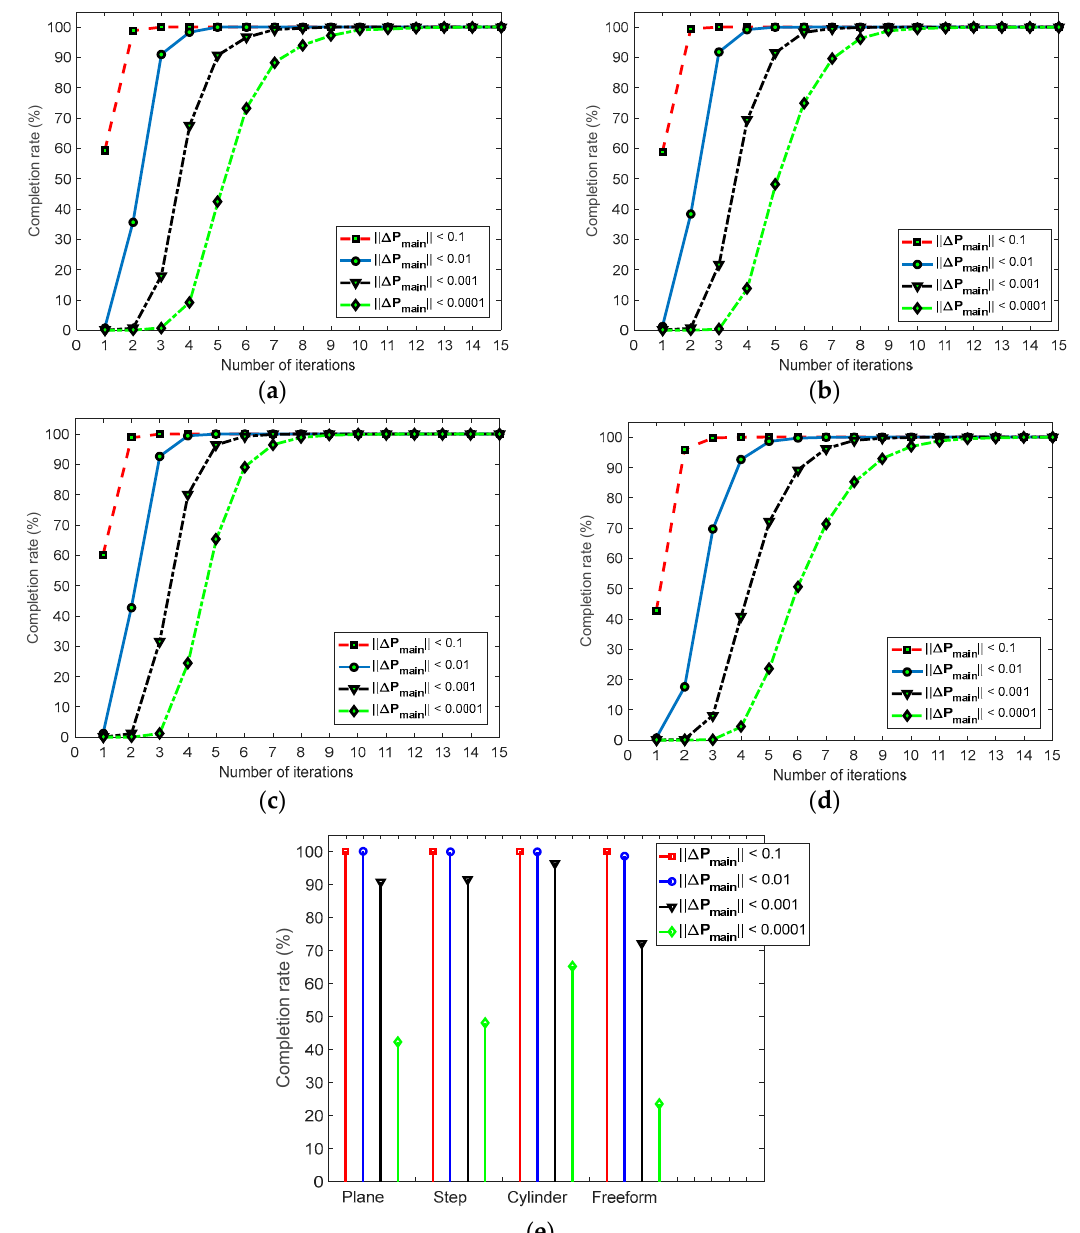
Figure 9. Efficiency evaluation of proposed seed point generation method: ( a ) plane surface; ( b ) step surface; ( c ) cylinder surface; ( d ) freeform surface; and ( e ) completion rate after five iterations.